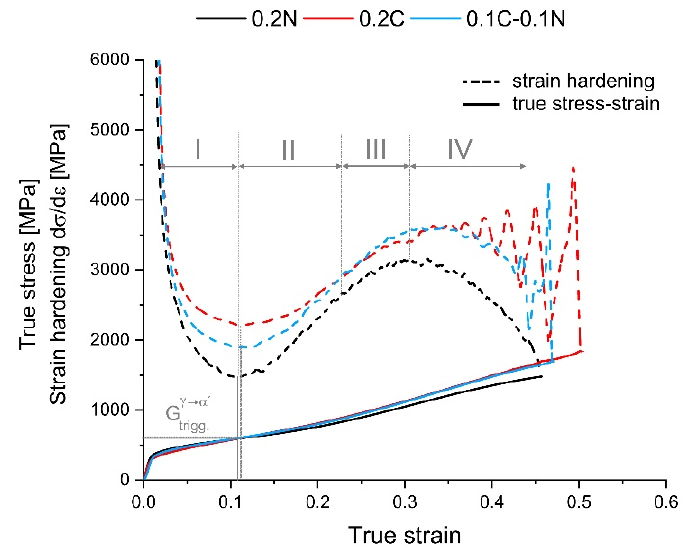
Figure 7. True stress–strain curves and strain hardening curves of the present steels at RT. The four stages of the strain hardening curve are exemplarily shown for the 0.2N steel.